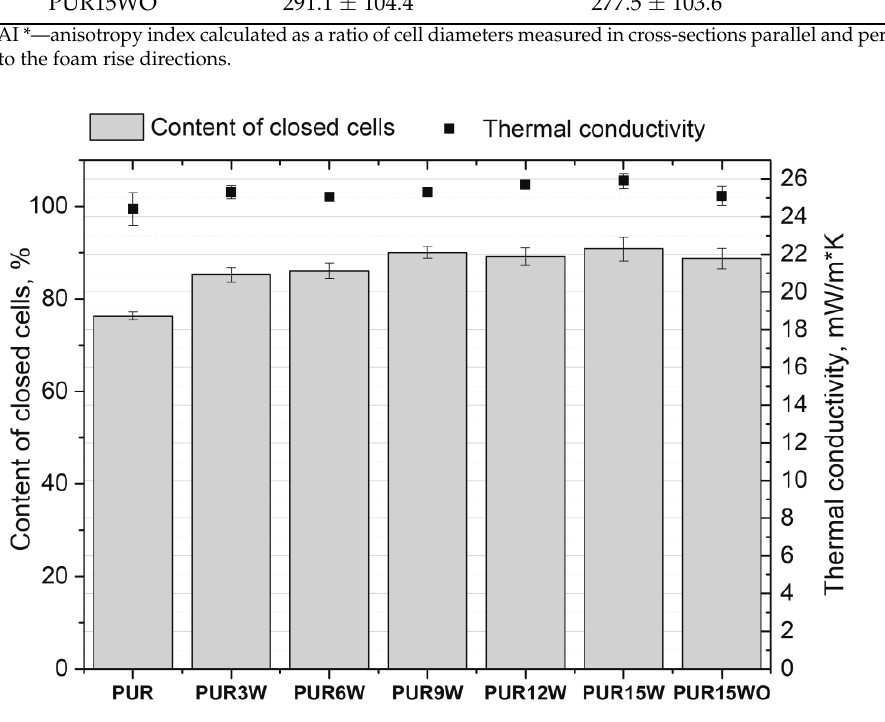
Table 3. Influence of vermiculite on the diameter of cells in PUR foams.